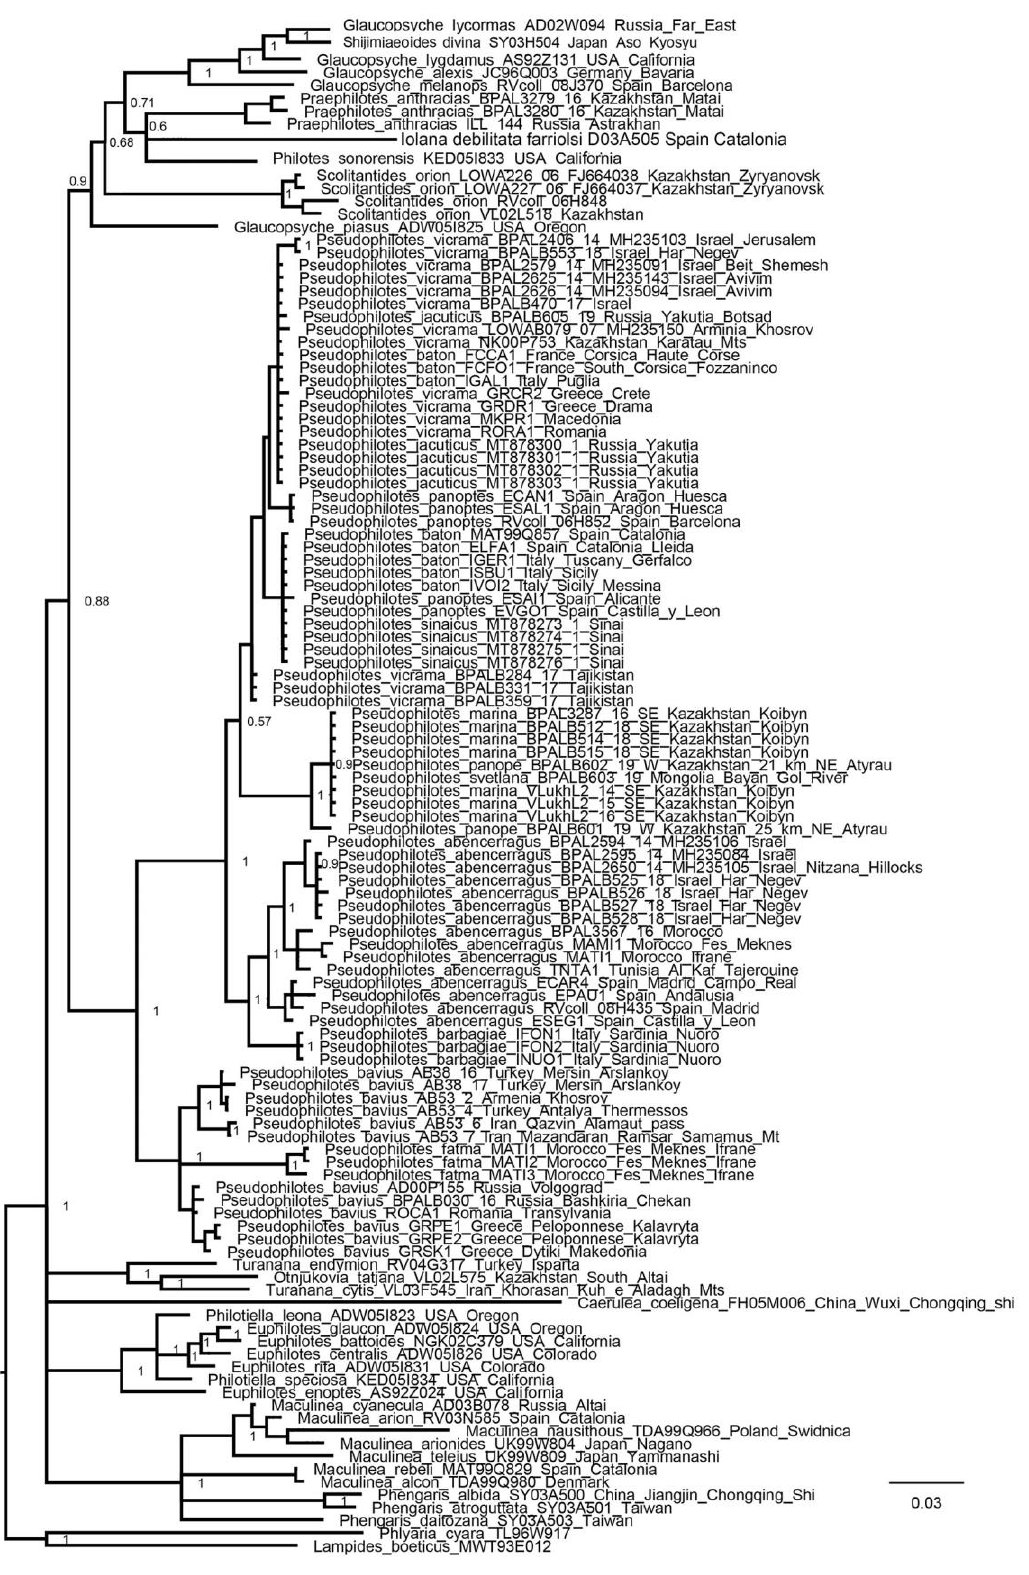
Figure 1. BI tree of the subtribe Scolitantidina based on mitochondrial genes ( COI +COII dataset). Posterior probabilities are indicated at the nodes.